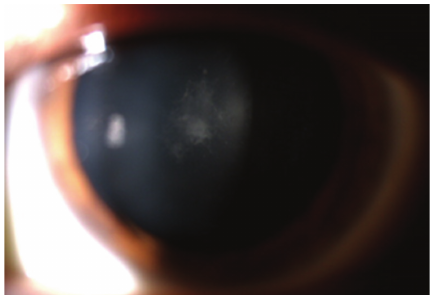
Figure 1: Mild subcapsular cataract in the left eye.